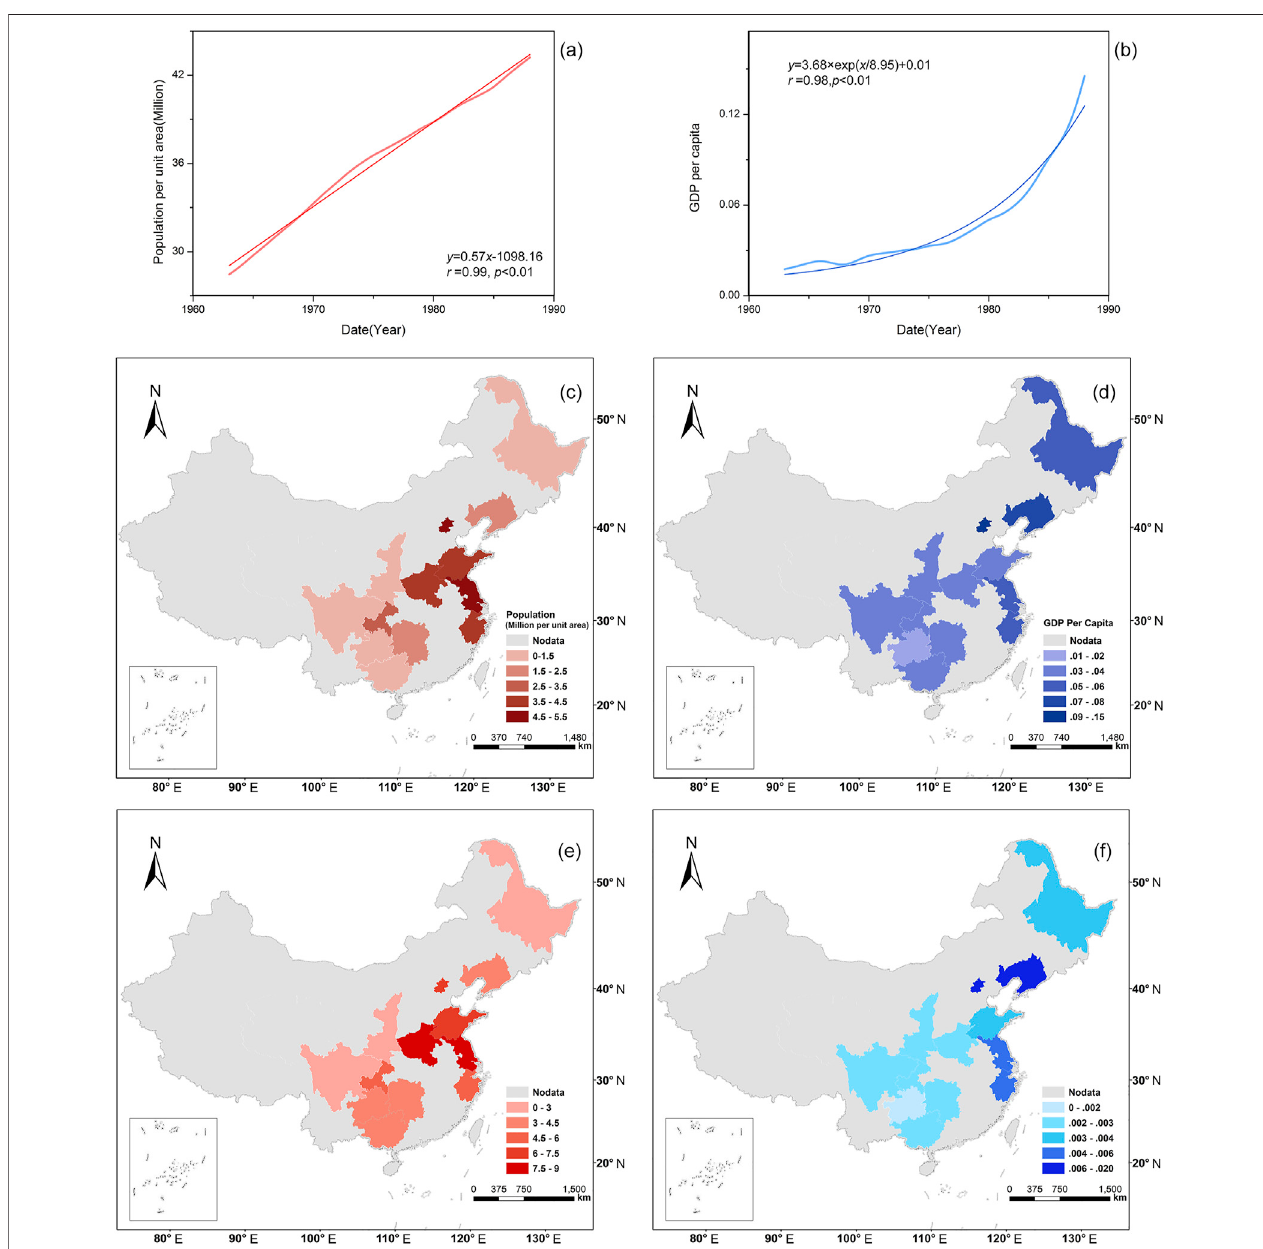
FIGURE 3 | The spatiotemporal dynamics of human activities at the study sites (1963 – 1988). (A) Inter-annual population density variation curves. (B) Inter-annual GDP per capita variation curves. (C) Spatial distribution of mean annual population densities (MAPD). (D) Spatial distribution of mean annual GDP per capita (MAG). (E) spatial distribution of the change trend in MAPD. (F) Spatial distribution of the change trend in MAG. The light gray areas in the fi gures represent the areas with no data, and in (E) and (F) , the color from light to dark indicates an increase in amplitude ( p <